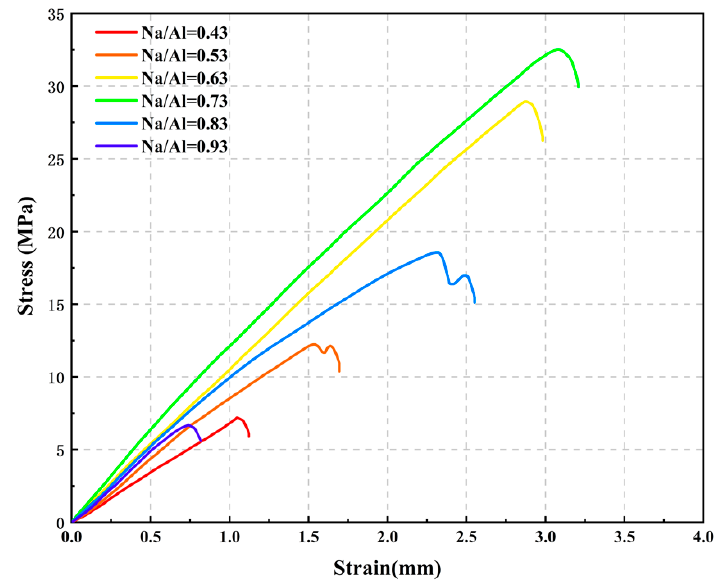
Figure 9. Stress–strain curves of MK-geopolymer with various Na/Al ratios at 28 days of curing.